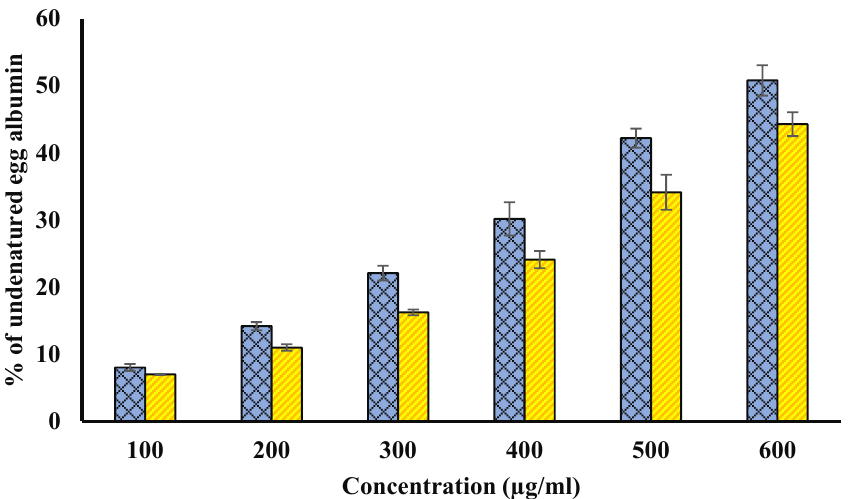
Figure 6. Percentage of undenatured egg albumin. Blue bars show percentage of undenatured egg albumin plot for various concentrations ( µ g/mL) of fruit pulp. However, yellow columns show the percentage of undenatured egg albumin plot for various concentrations ( µ g/mL) of seed extract. The p -value significance was found to be less than 0.05 for this figure ( p < 0.05).